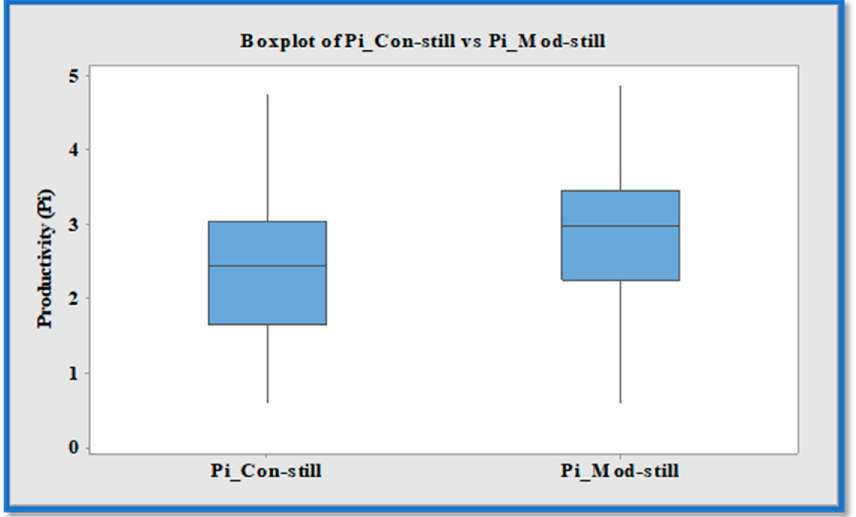
Figure 10. Boxplot of observed productivity values for the con-still and